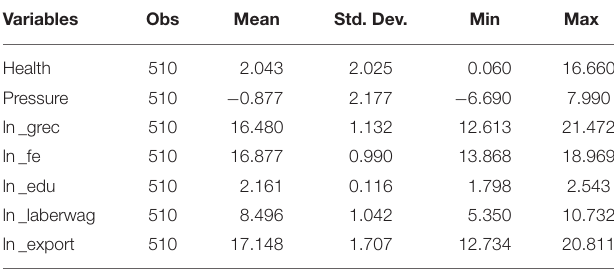
TABLE 1 | Descriptive statistics of the